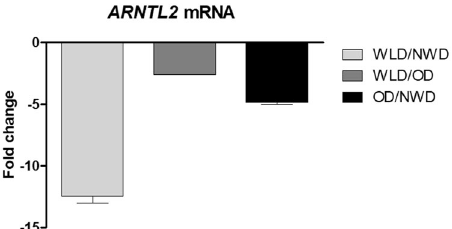
Fig. 1 ARNTL2 expression is downregulated upon weight-loss (WL) in human ASCs. Microarray analysis of freshly isolated